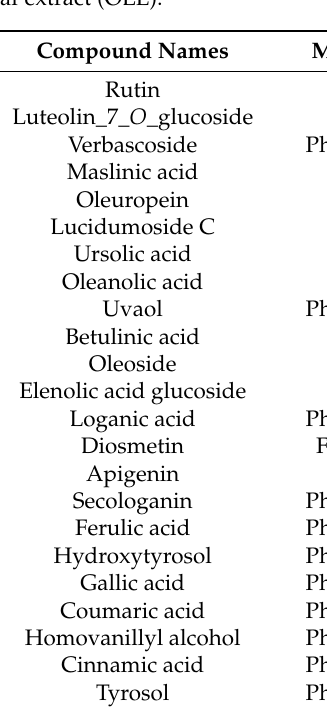
Table 1. List of bioactive compounds, their micro constituents and molecular formula present in olive leaf extract